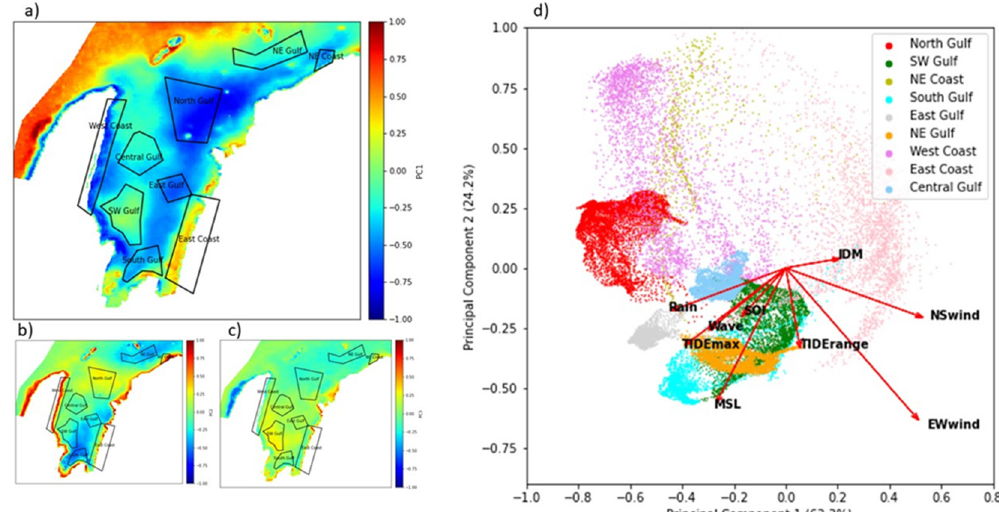
Figure 10. ( a – c ) Principal components 1, 2 and 3 (respectively) with overlay of nine geographical regions used to construct the biplot; ( d ) bi-plot showing the first two principal components that explain environmental drivers of turbidity from nine regions in the Exmouth Gulf. The cosine of the angles between the variable arrows estimates the correlations between the variables (from Table 3), the smaller the angle the higher the correlation. The length of arrows is roughly proportional to the standard deviation in the correlations for that variable, meaning that the longer the arrow, the more that variable is responsible for separating the groups.